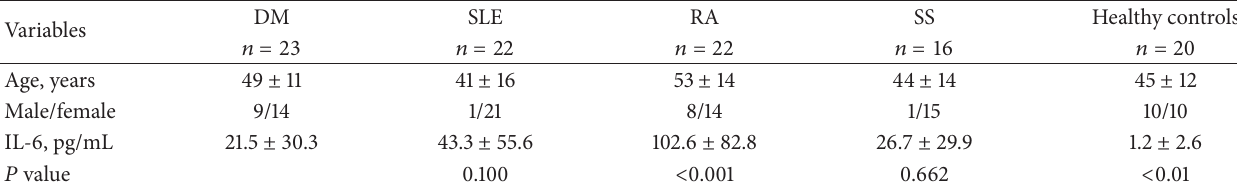
Table 1: The demography and the IL-6 levels in DM patients and controls.